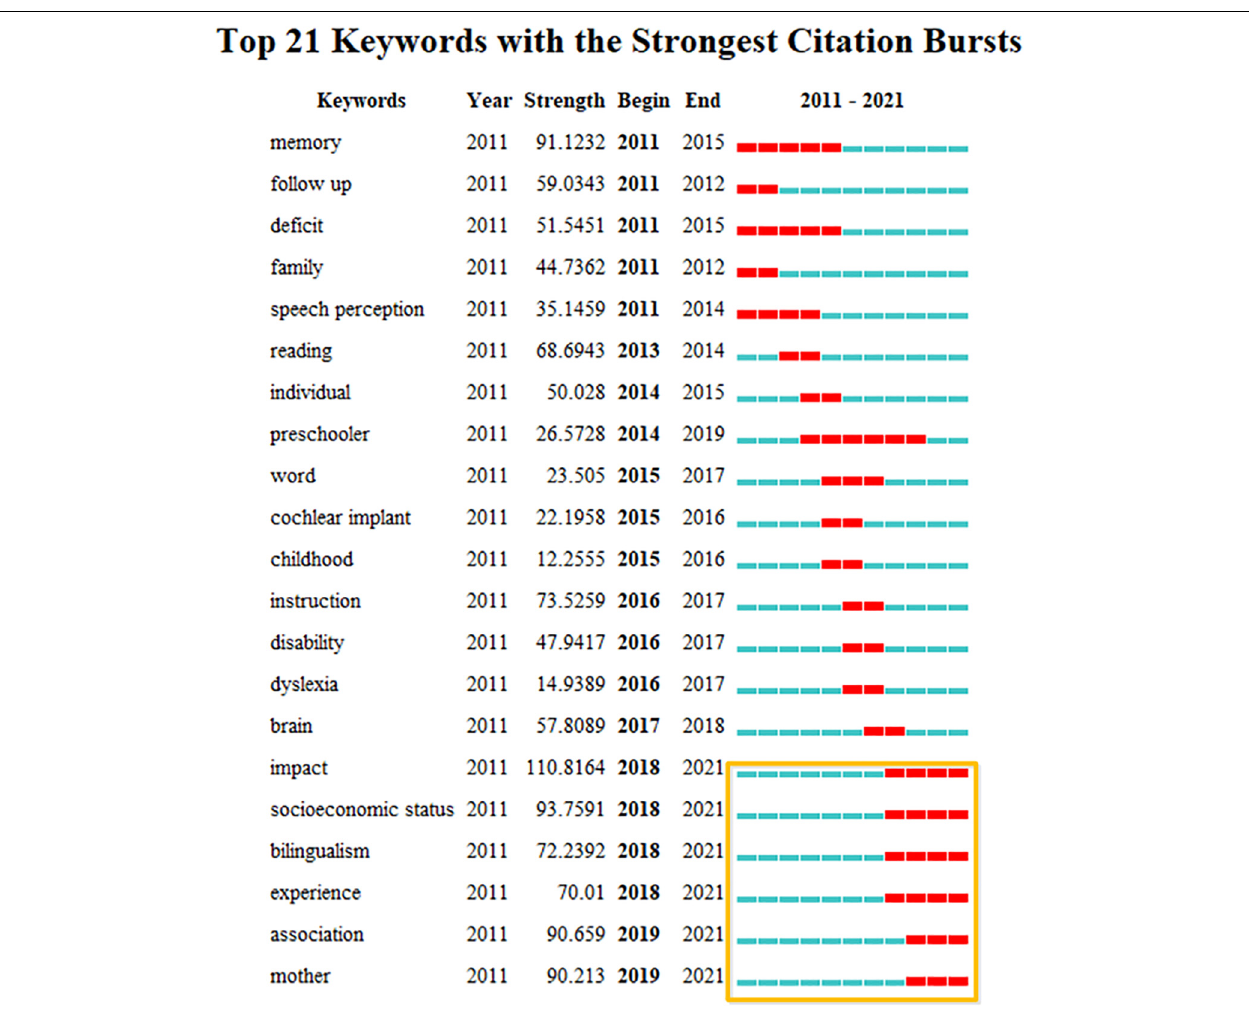
FIGURE 11 | Twenty-one keywords with the strongest citation bursts between 2000 and 2020 about CL research sorted by strength.